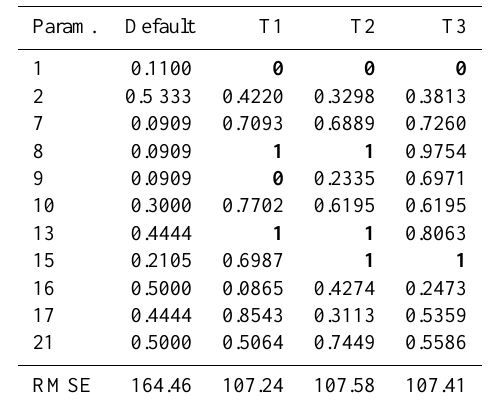
Table 7. Default and optimized parameter values of optimization trials T1, T2, and T3 for the 11-dimensional real data case. Bold indicates optimized parameters that are on the variable bound (all variables are scaled to [0,1]).